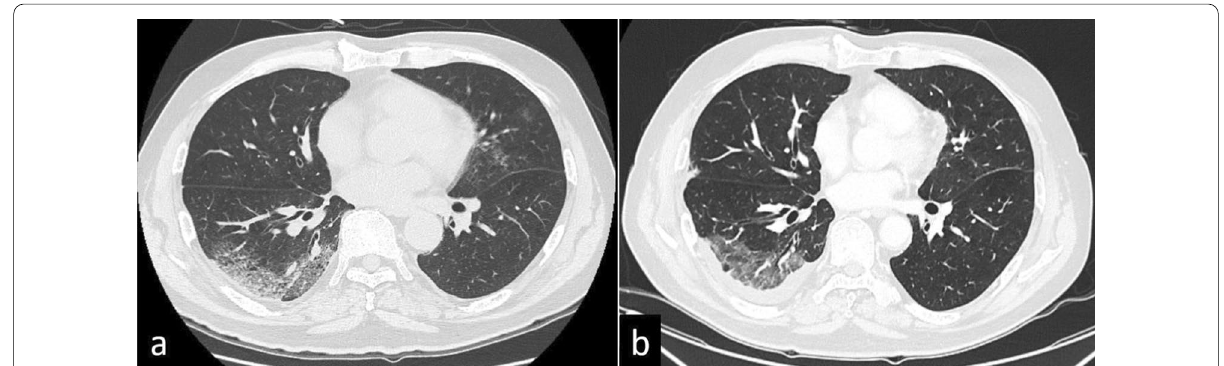
Fig. 2 Lung findings of case 1 on chest computed tomography. a Peripheral ground-glass opacities and band-like opacities were found in bilateral lower lobes immediately after COVID-19 infection. b The ground-glass opacities regressed 23 days before the